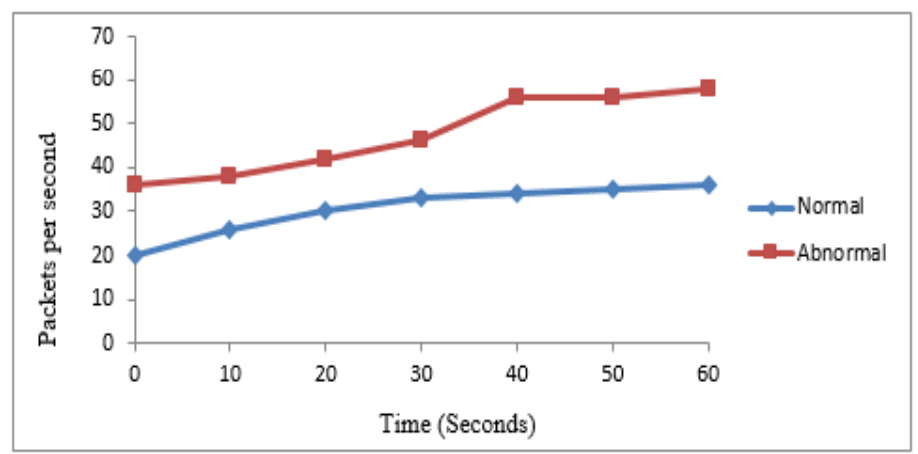
Figure 6. Experiment 2 for categorization of traffic.